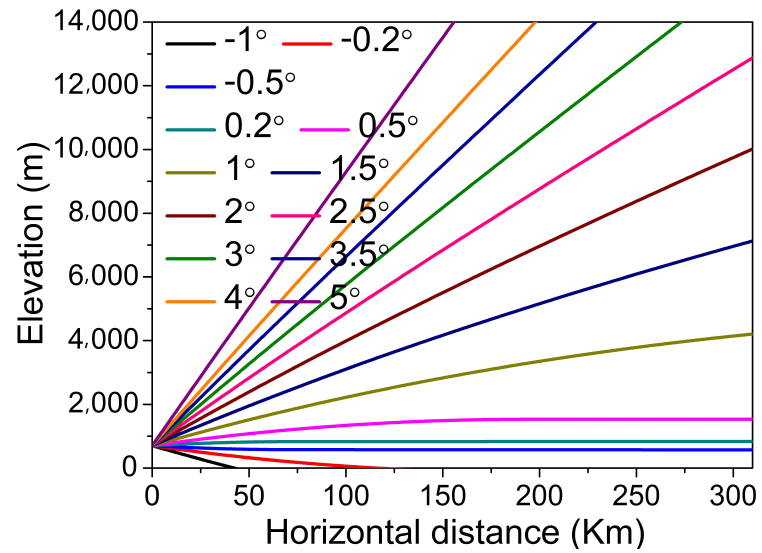
Figure 4. The propagation paths of radio waves with different incident angle.